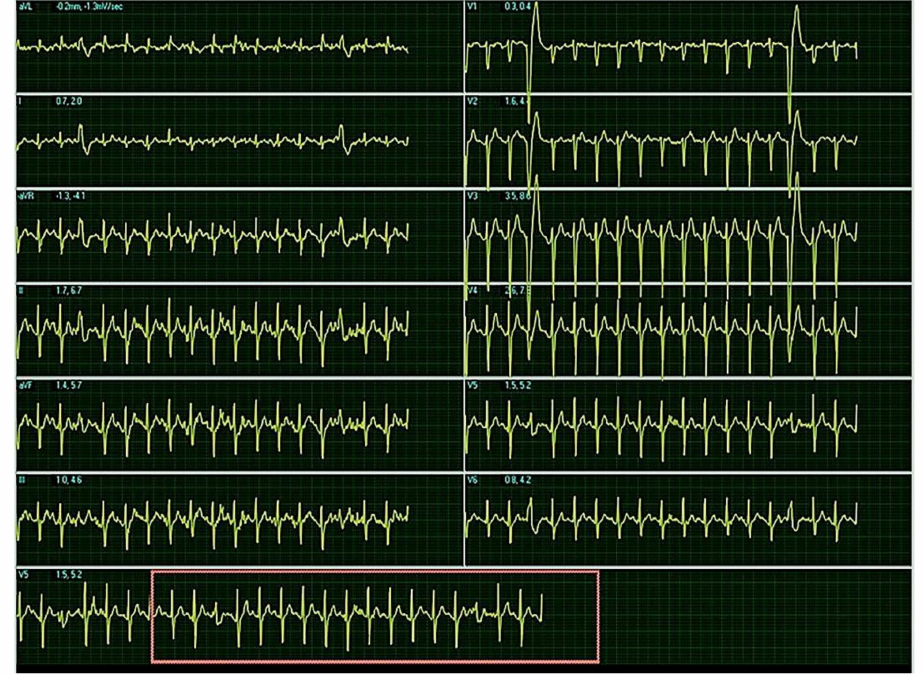
Figure 3. Electrocardiogram during cardiopulmonary test: sinus tachycardia, heartrate = 166/min, AxQRS + 70, narrow QRS complex, R/S in leads D2, D3, aVF, r/S in leads V2, V3 with unifocal premature ventricular complexes with left bundle branch block morphology. Ambulatory 24-h ECG monitoring recorded 1535 PVCs and several episodes of